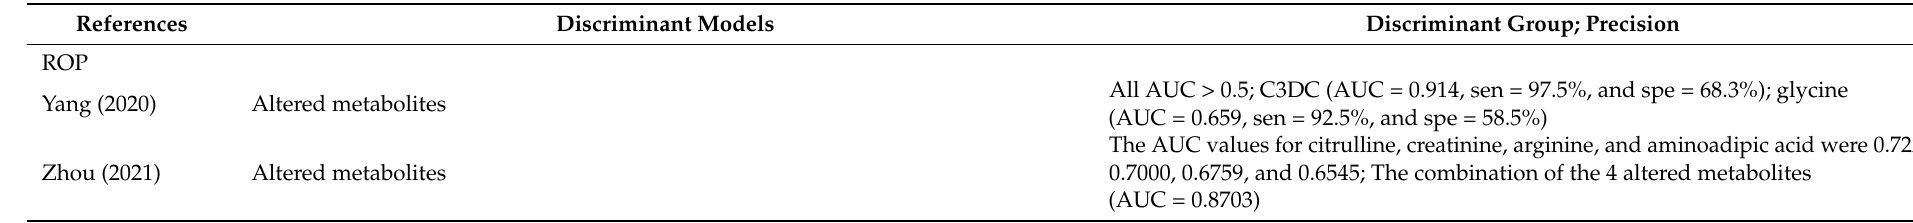
Table 3. Classification/Prediction Potential of Biomarker